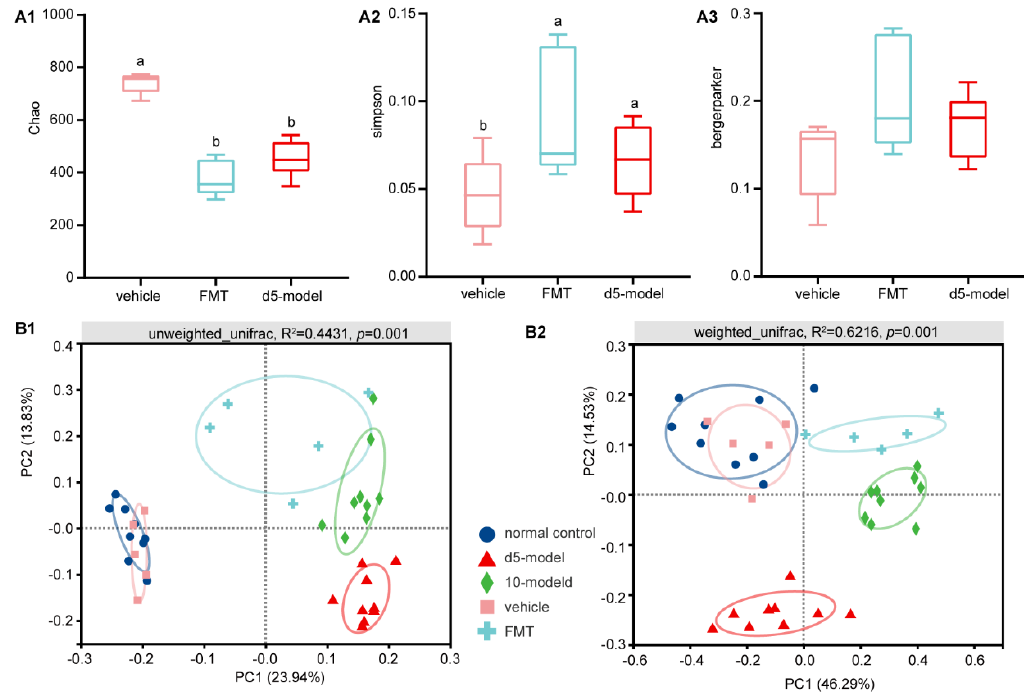
Figure 6. The changes in gut microbiota diversity after FMT. ( A ) Alpha diversity changes. ( B ) Principal coordinate analysis by unweighted UniFrac ( left ) and weighted UniFrac method ( right ), n = 5. Data are compared using Kruskal – Wallis tests with Benjamini – Hochberg correction, different lowercase letters within each group indicate significantly different values.